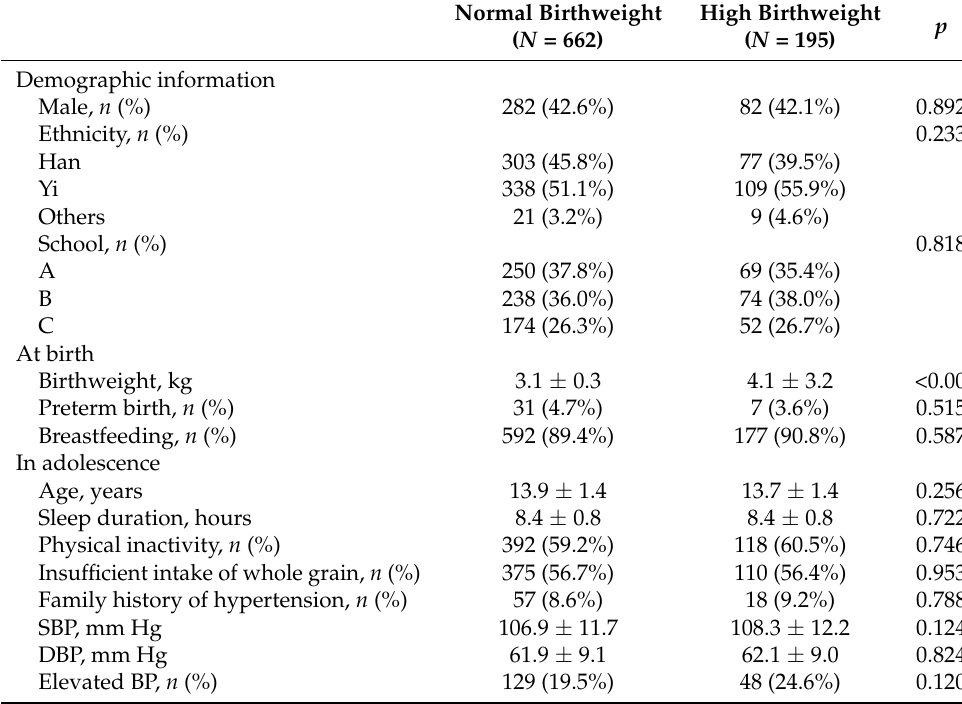
Table 1. Characteristics of the participants stratified by birthweight.